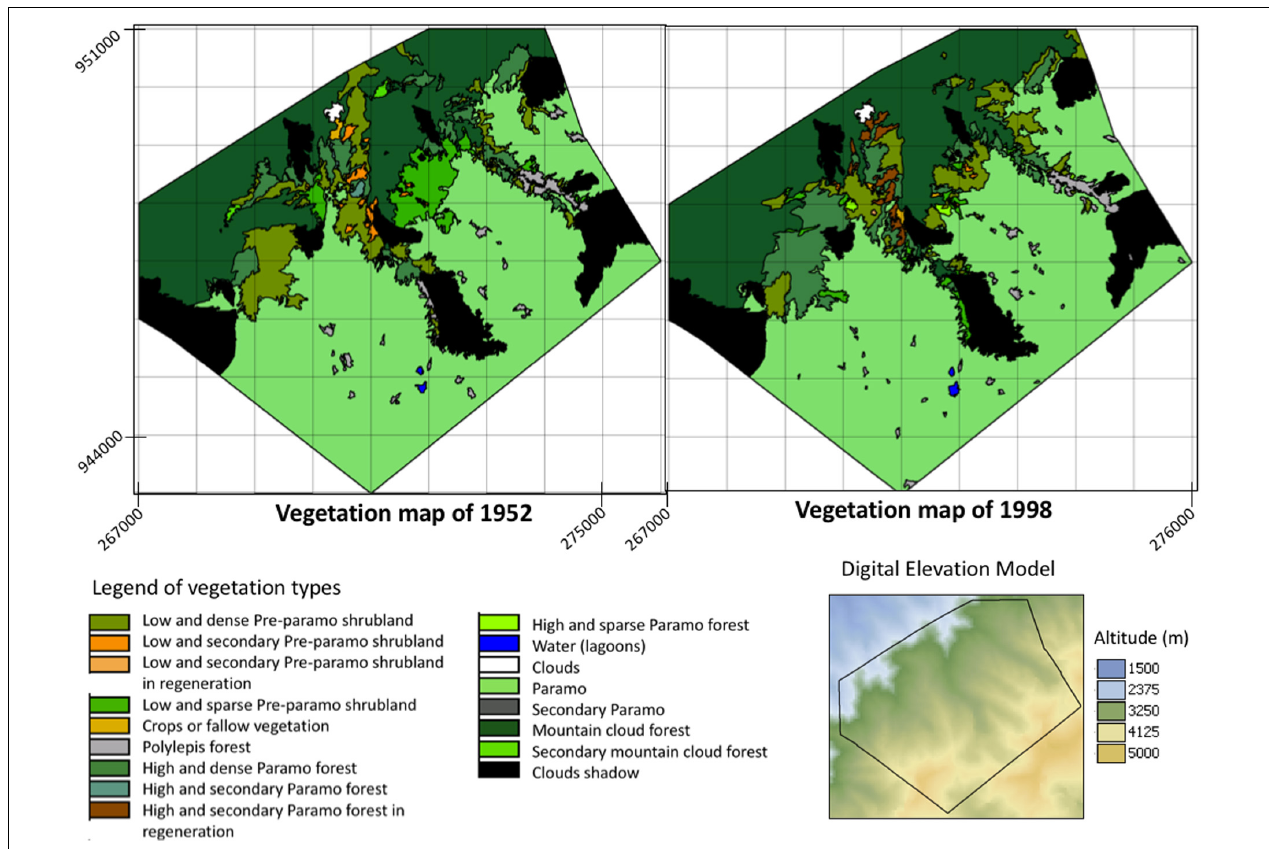
FIGURE 5 | Vegetation maps of Sierra Nevada National Park study area, for 1952 and 1998, Cordillera de Mérida, Venezuela. Legend of vegetation types is presented. The Digital Elevation Model (DEM) of the study area is shown, as well, the elevation gradient. Coordinates in the UTM system are